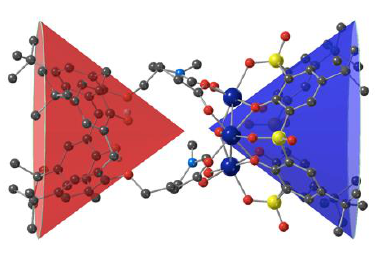
Figure 6. Schematic representation of the trinuclear complexes M 3 (H 2 O)(DMF) 2 -( 2 -2H)- 3 (M = Co II , Ni II and Zn II ) with ( 2- 2H) 2− (red) and 3 4− (blue).